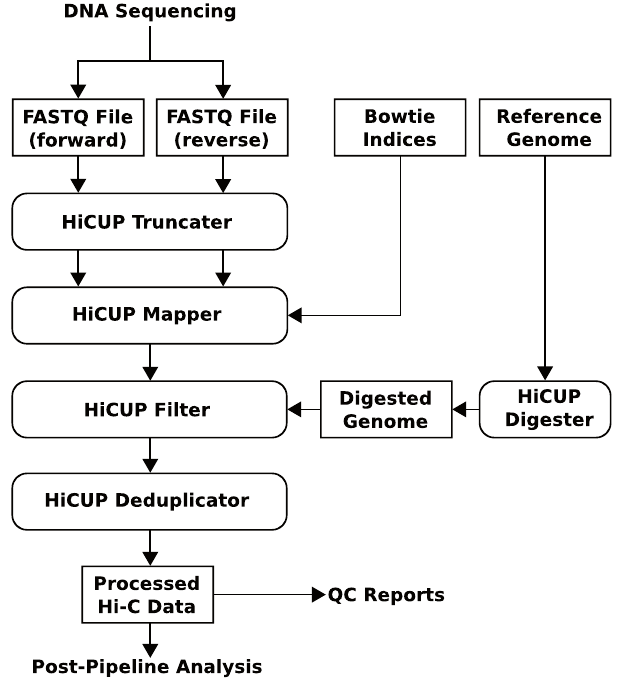
Figure 3. Flow diagram summarising the HiCUP pipeline. HiCUP takes FASTQ files generated by DNA sequencing and produces cleaned mapped data accompanied with QC reports. The bulk of the pipeline comprises 4 scripts: Truncater, Mapper, Filter and Deduplicator. These are executed in turn by the HiCUP master script which controls data flow through the pipeline. (The diagram uses rectangles with angled or rounded edges to represent data files or HiCUP Perl scripts